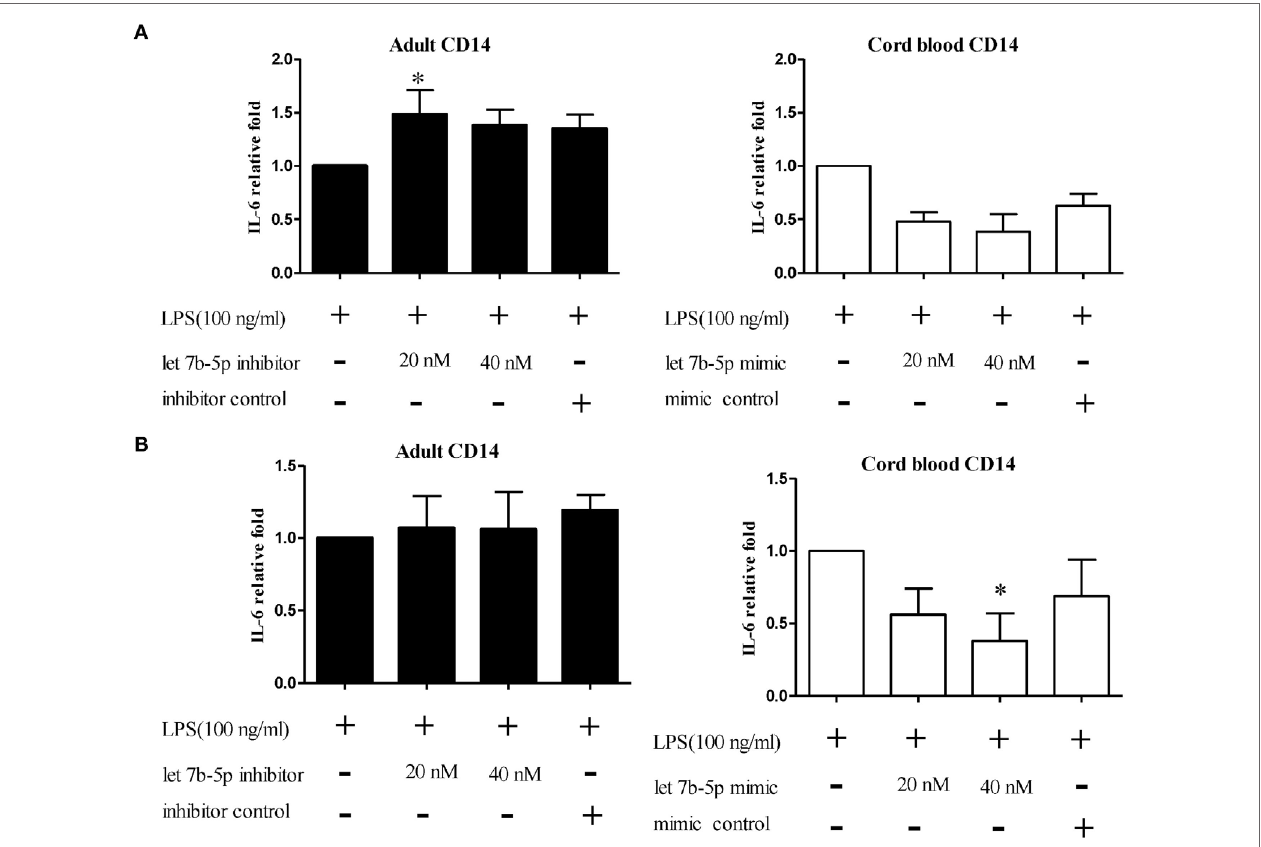
FigUre 13 | The effect of let-7b-5p on interleukin (il)-6 production by monocytes . let-7b-5p inhibitor transfected or untransfected adult monocytes and let-7b-5p mimic transfected and untransfected CB monocytes were subjected to detection of the IL-6 protein after LPS stimulation for 16 h. The transfection times were (a) 24 h and (B) 48 h. IL-6 production is represented as relative fold expression compared to the LPS stimulation control. * p < 0.05 as compared with LPS stimulation only with Mann–Whitney U test ( n =